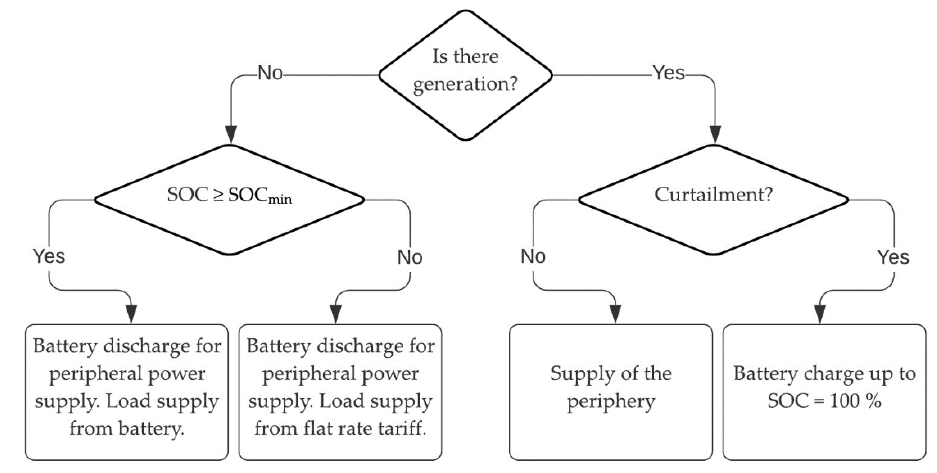
Figure 6. Control algorithm for the adopted model.